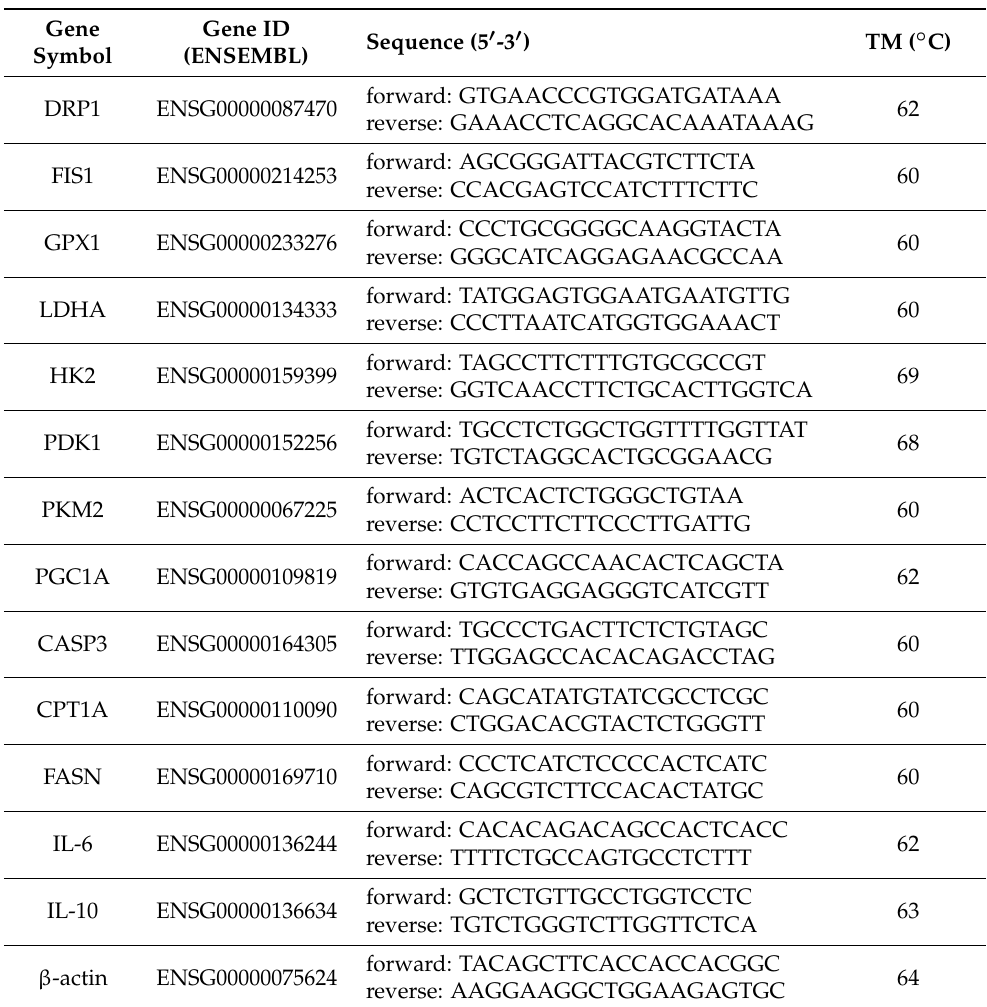
Table 1. List of